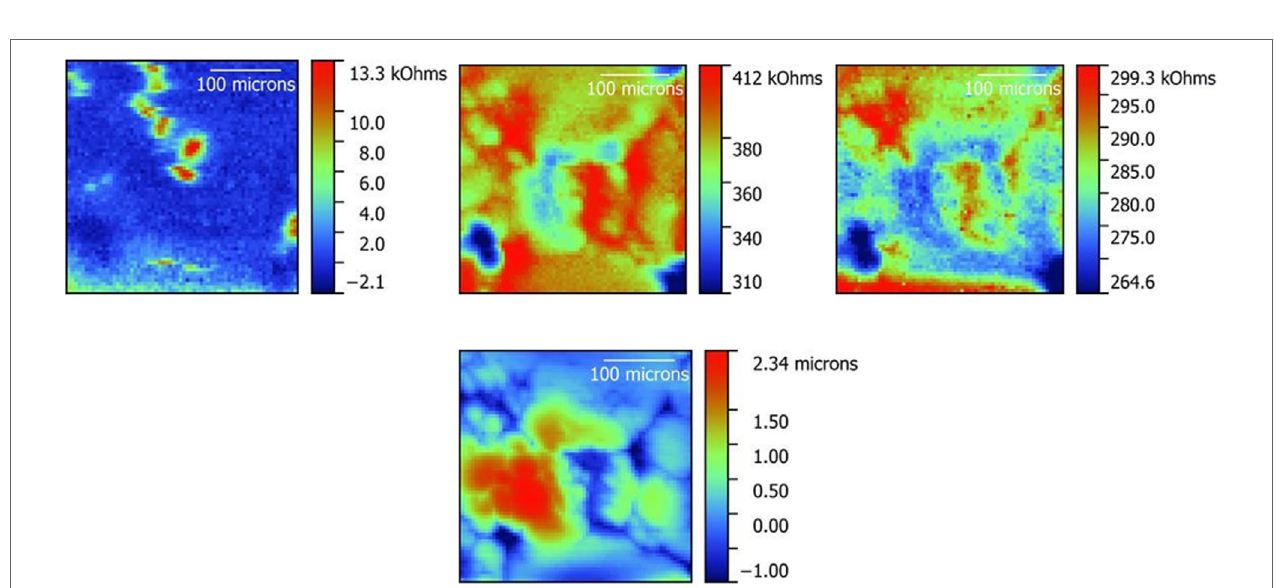
FigUre 4 | impedance maps obtained on an unpolished llZO pellet in ac-secM mode (left), ic-ac-secM mode (middle), and ac-secM mode with height tracking (right) . A topography map obtained from the ic-ac-SECM experiment is also shown below the ic-ac-SECM impedance map in the middle. A 325 μ m × 325 μ m area was studied. White and black arrows in the ic-ac-SECM impedance and topography maps point to areas of interest as explained in the